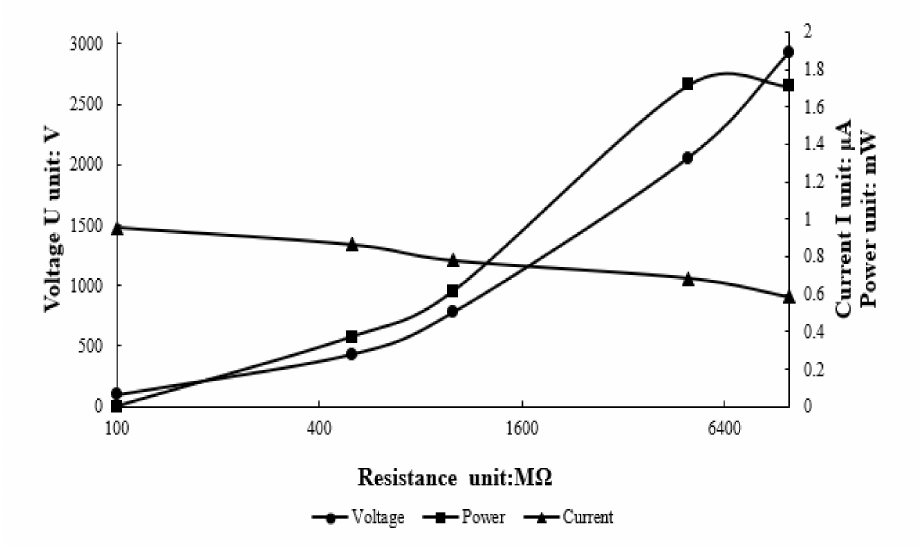
Figure 7. Peak power, current and voltage vary with